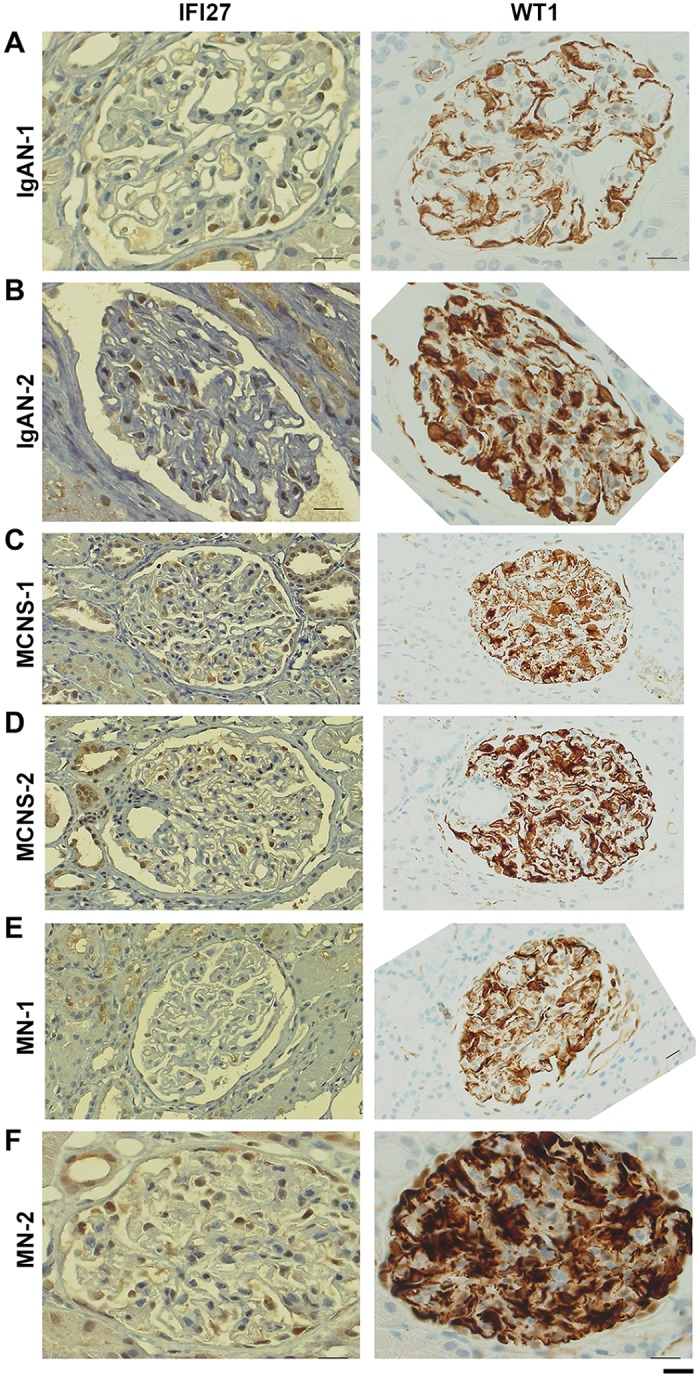
Distribution of IFI27-immunostained dots in the glomeruli of IgAN, MCNS, and MN patients.(A–F) Typical images of IFI27 immunohistochemistry (160×) in renal specimens from two IgAN, two MCNS, and two MN patients. Gender and age of these patients are shown in S4D Fig. Bar, 20 μm.